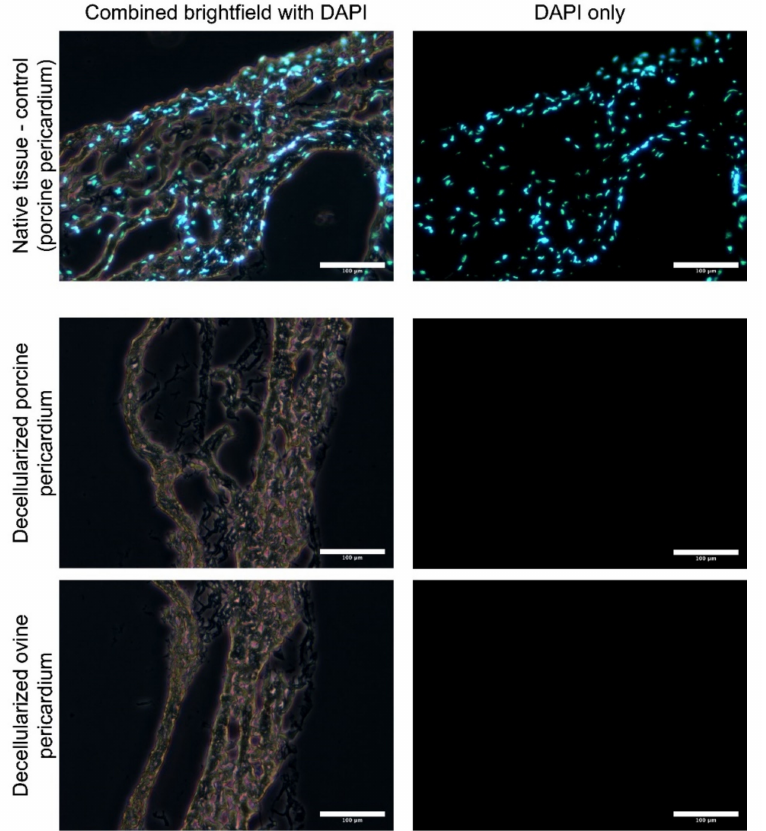
Figure 2. Thin cryosections (7 µ M) of native and decellularized porcine and ovine pericardia stained with DAPI. Cell nuclei are visible in native tissue; however, neither nuclei nor fragments were observed in the decellularized